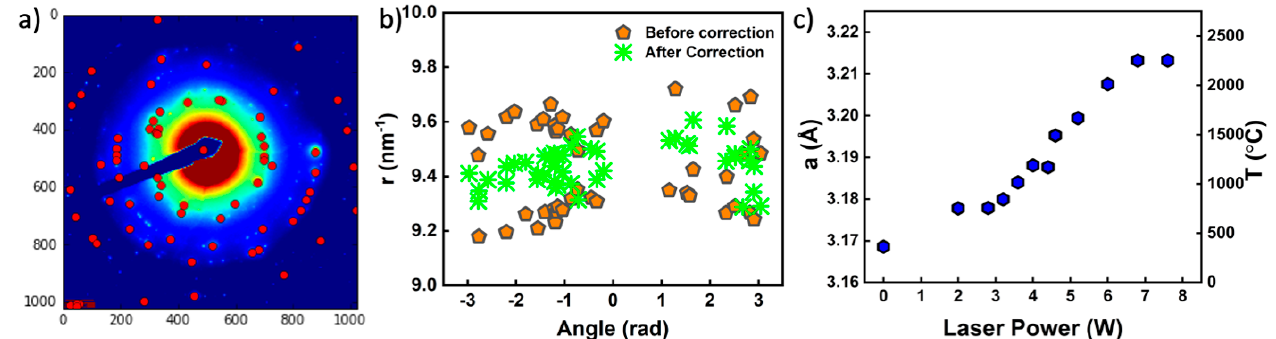
Figure 1. ( a ) Example colorized electron diffraction pattern obtained from tungsten showing He location of diffraction spots identified by a custom python code. ( b ) Uncorrected and corrected positions of diffraction spots associated with a set of reflections. ( c ) Plot of the calculated lattice parameter as a function of applied laser power.